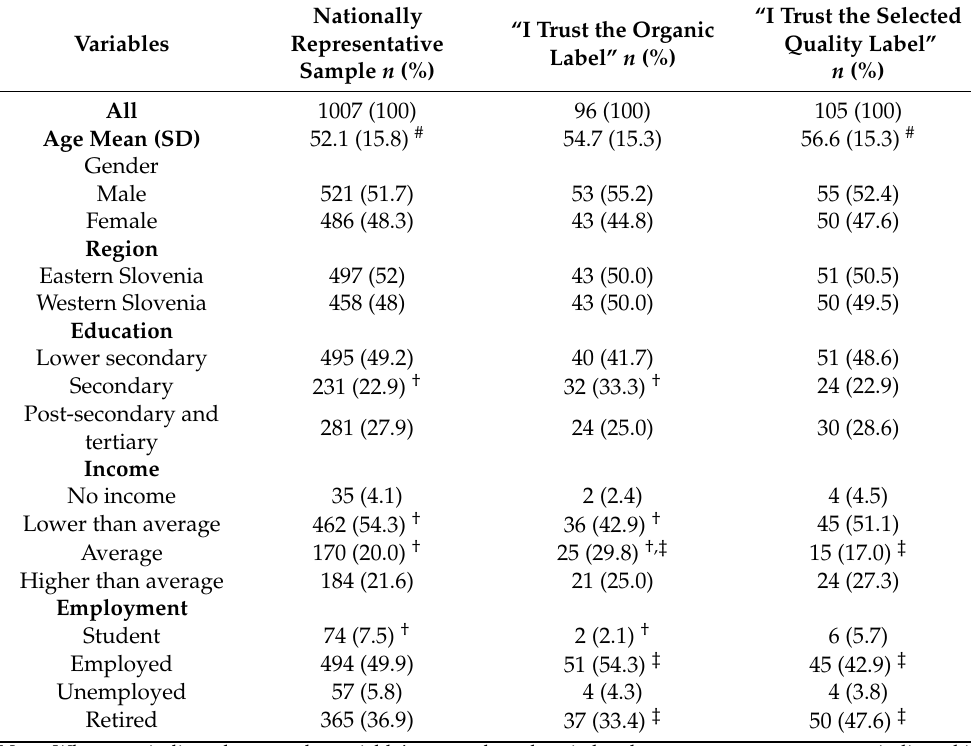
Table 4. Sociodemographic Characteristics of the Total Sample and Segments ( n =